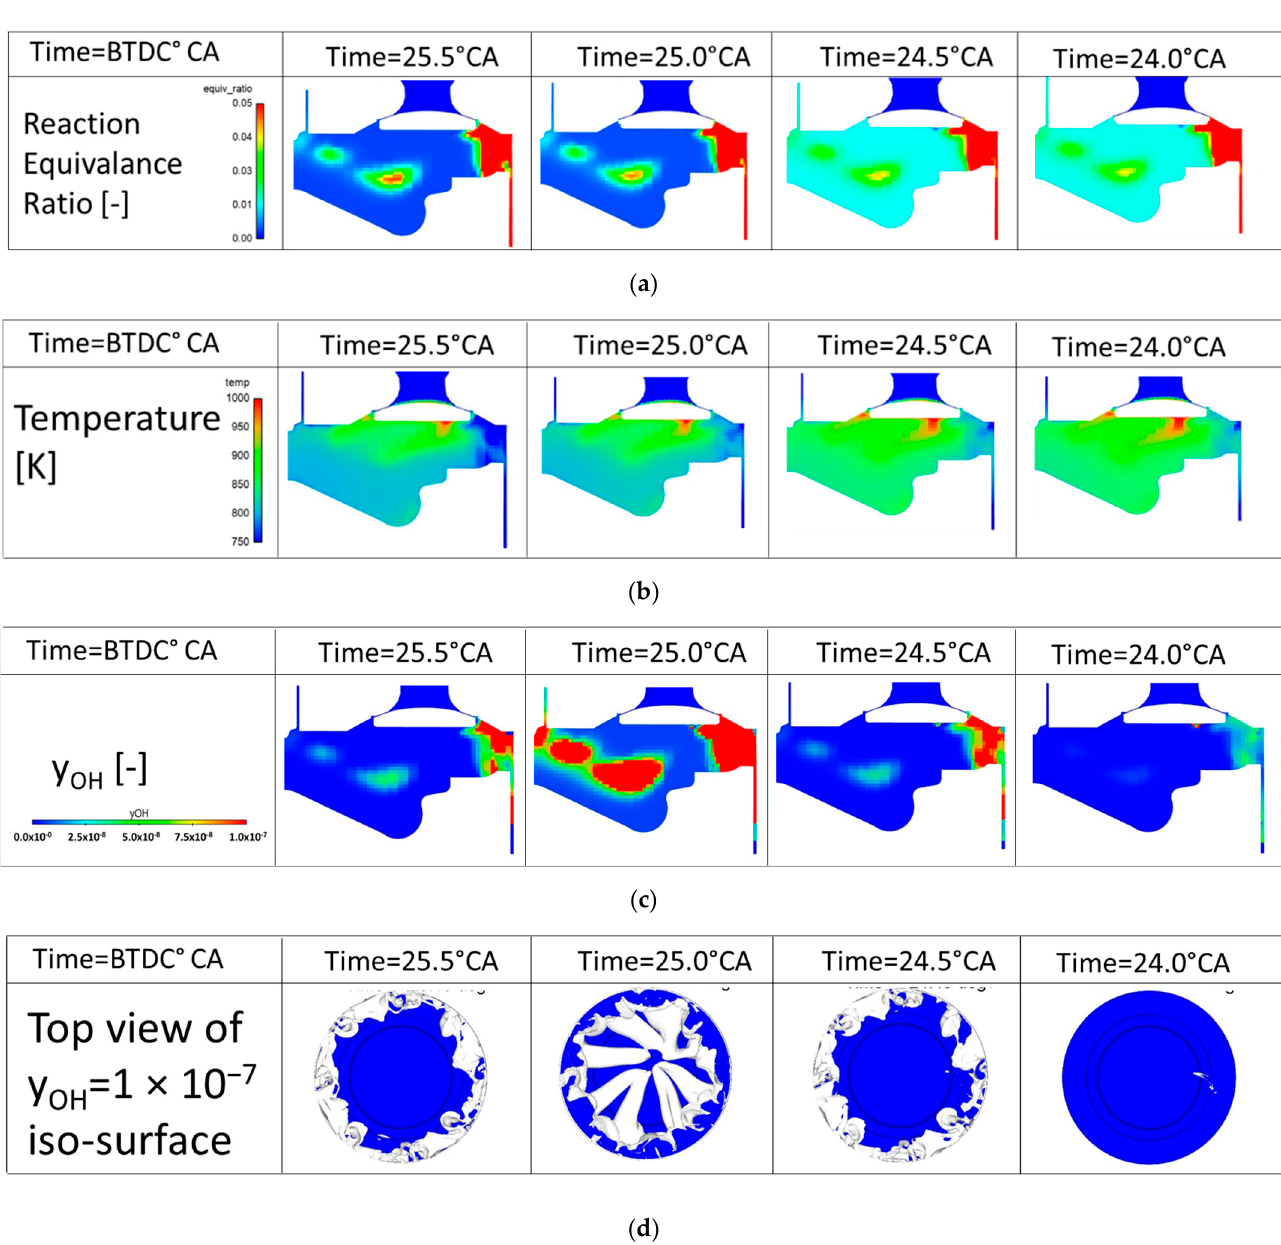
Figure 6. Section views of ( a ) RER; ( b ) temperature; ( c ) OH mass fraction; ( d ) top view of OH mass fraction of 1 × 10 − 7 iso-surface during the first heat release peak according to °CA BTDC for SOI of − 50 °CA ATDC.